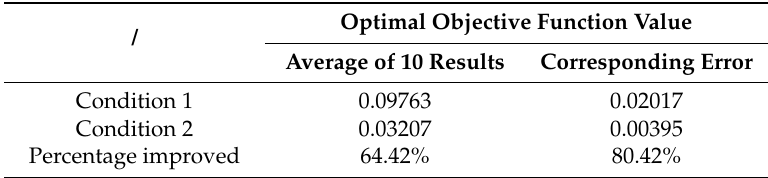
Table 3. Comparison of the calculated results under two